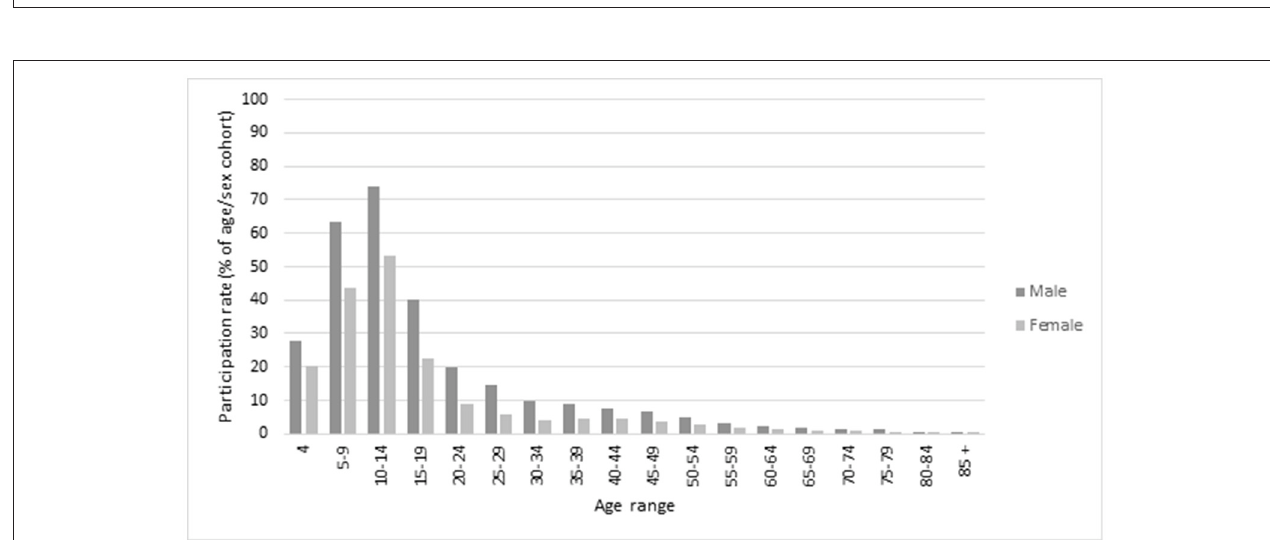
FIGURE 2 | Participation rates in 10 sports, 2019, Victoria: by sex and age.